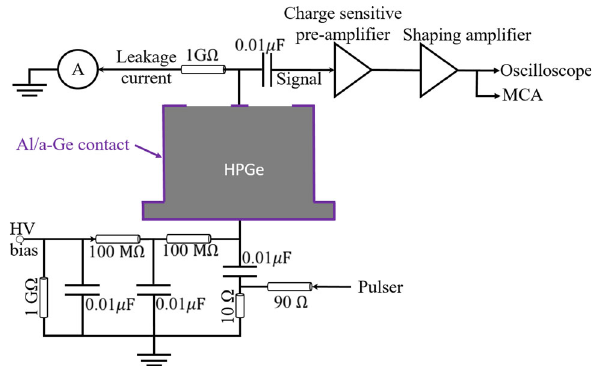
Fig. 7 Electronic circuit for detector characterization